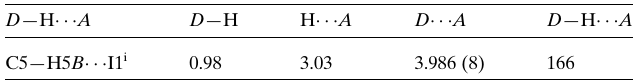
Table 3 Hydrogen-bond geometry (A˚ , (cid:4) ) for 3 .